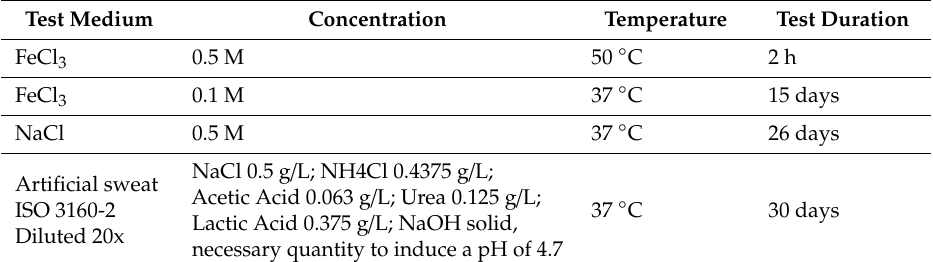
Table 3. Types of electrolytes used and the experimental conditions for testing pitting corrosion